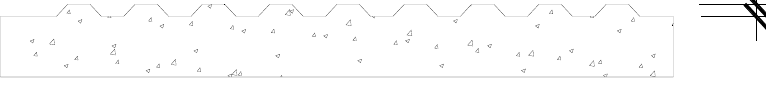
Figure 2. Roughness definition.